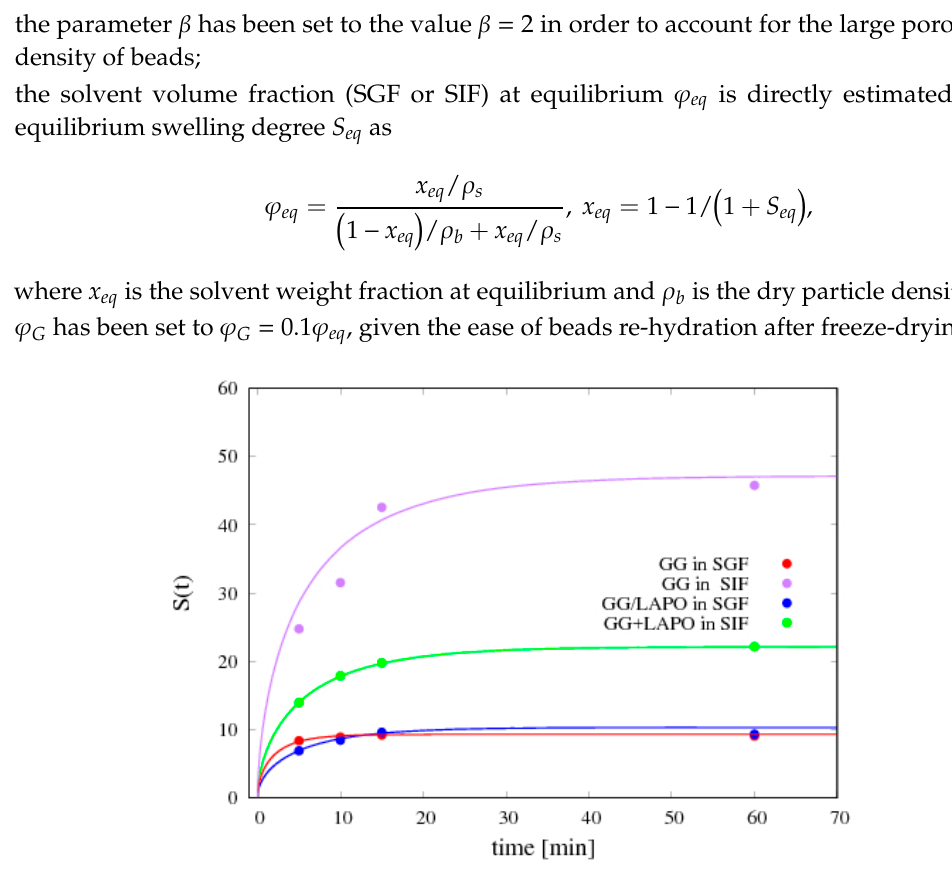
Figure 7. Comparison between the swelling model predictions (continuous lines) and experimental data (points) for the temporal evolution of the swelling degree S(t) for two different bead formulations (GG/Ca 0.3% and GG/LAPO/Ca 0.3%) and two different swelling media (SGF and SIF). The best fit values for the solvent diffusion coefficient in the swollen gel D ssg are reported in Table 2.